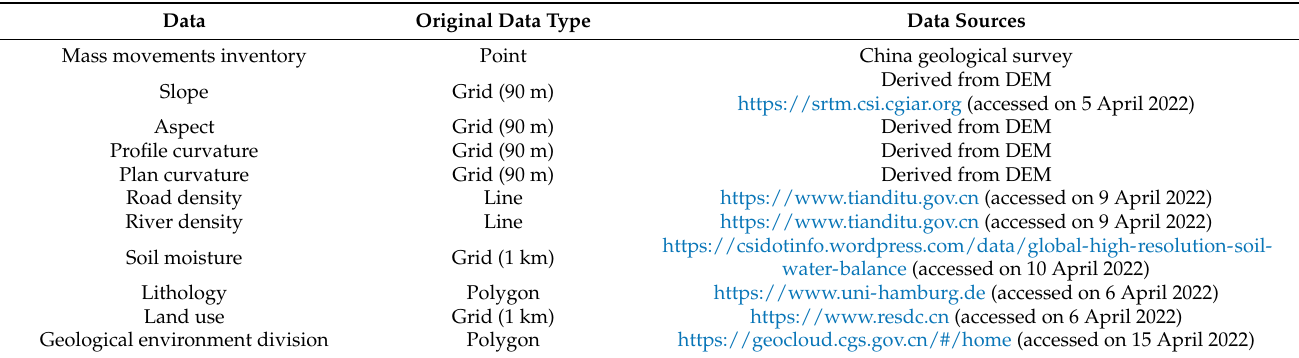
Table 1. Data type and sources of mass movements inventory and influencing factors.